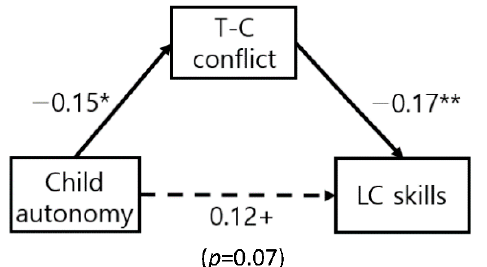
Figure 1. Locomotion skills of boys and girls (no gender difference). + p < 0.10, * p < 0.05, ** p < 0.01.